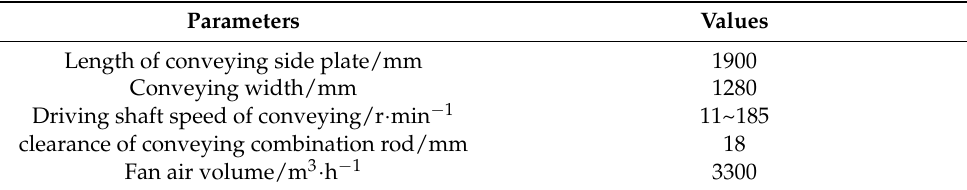
Table 2. The conveying and separating device parameters.